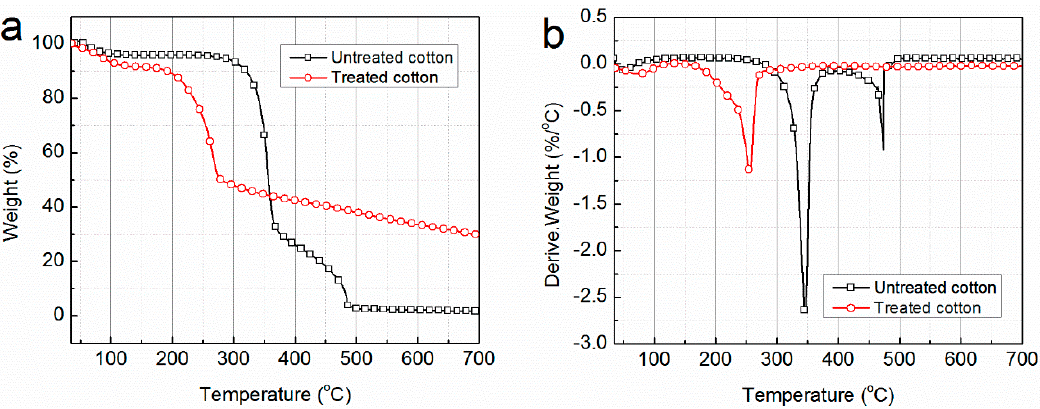
Figure 3. TG ( a ) and DTG ( b ) curves of untreated and treated cotton fabrics in air atmosphere.